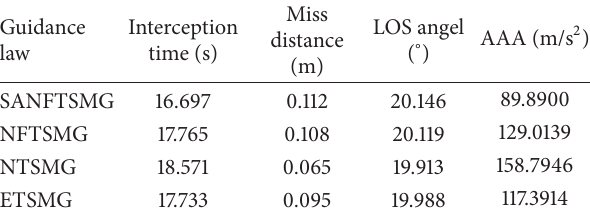
Table 5: Summary of simulation results in Case 1